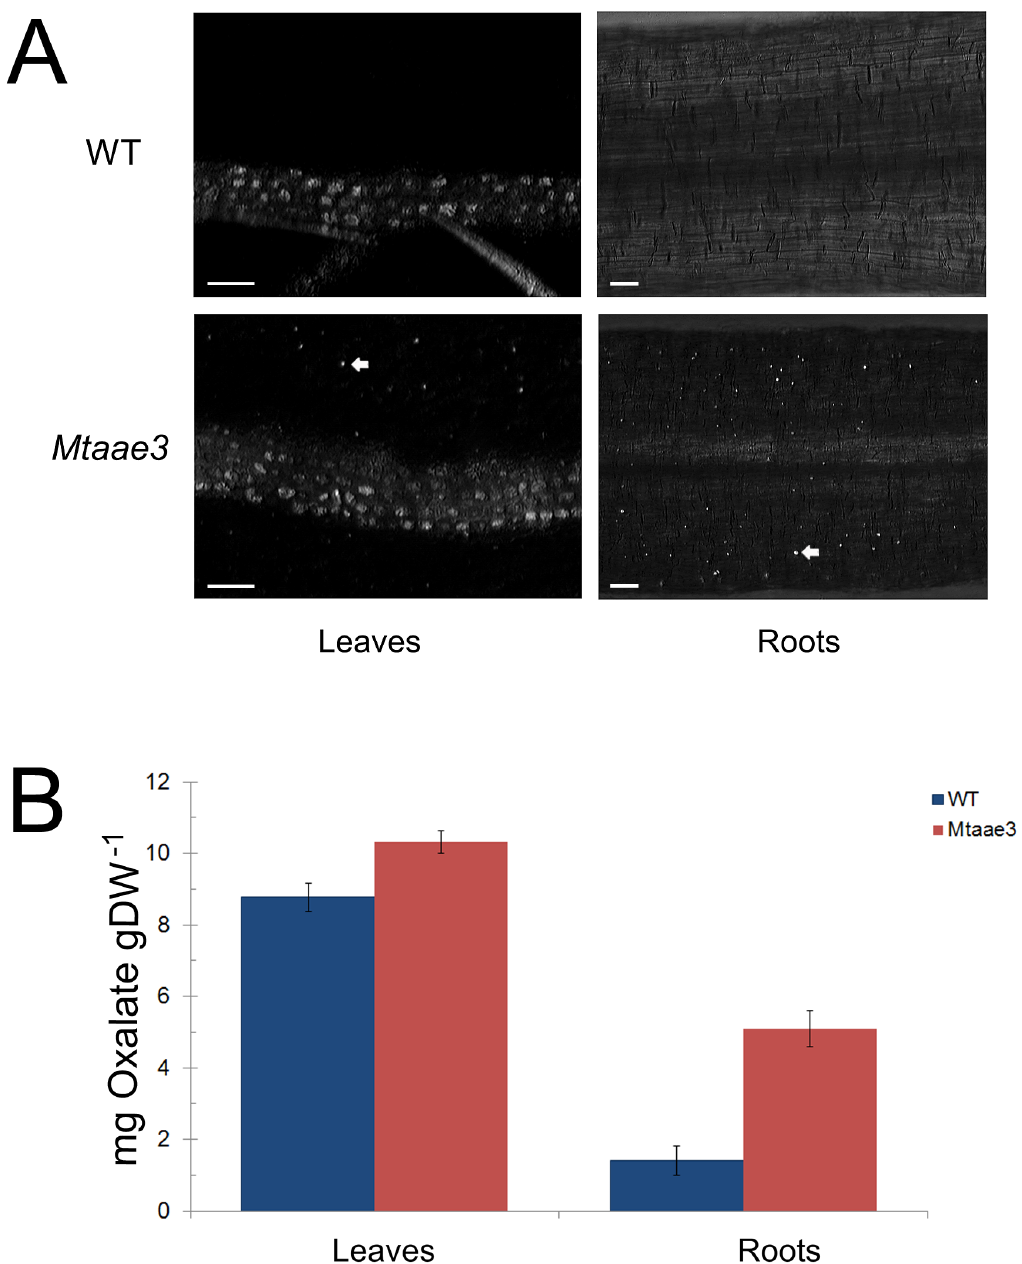
Fig 6. Assessment of Mt AAE3 in the regulation of calcium oxalate accumulation. (A) Comparison of the crystal phenotypes in leaf and root from WT and Mtaae3 knock-down plants. Crystals are bright spots denoted by arrows. (B) Total oxalate in leaf and root from WT and Mtaae3 RNAi knock-down plants. Bar = 50 μ